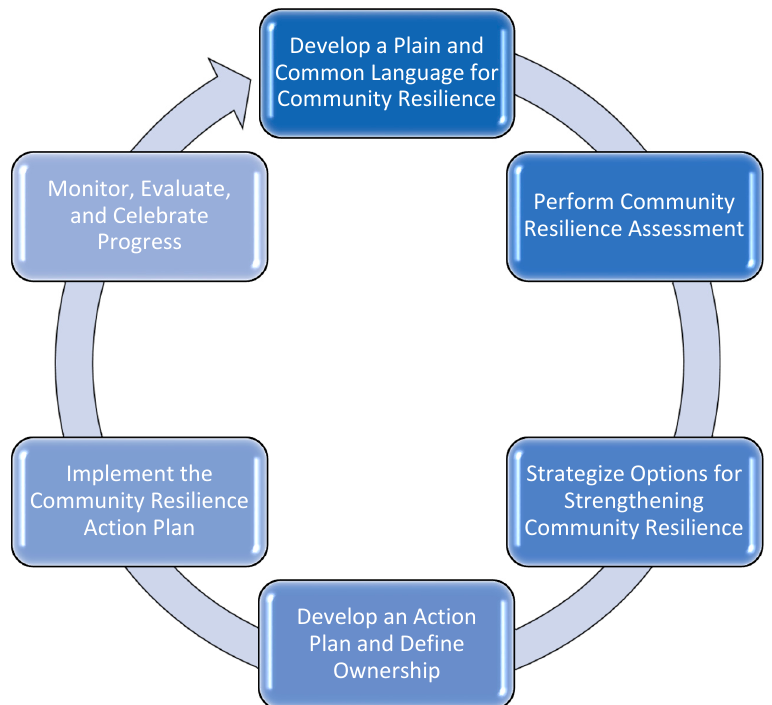
Figure 4. Participatory Visioning-Planning-Acting Cycle * using the COPEWELL Rubric to Enhance Community Resilience (Adapted from References [41,47]).